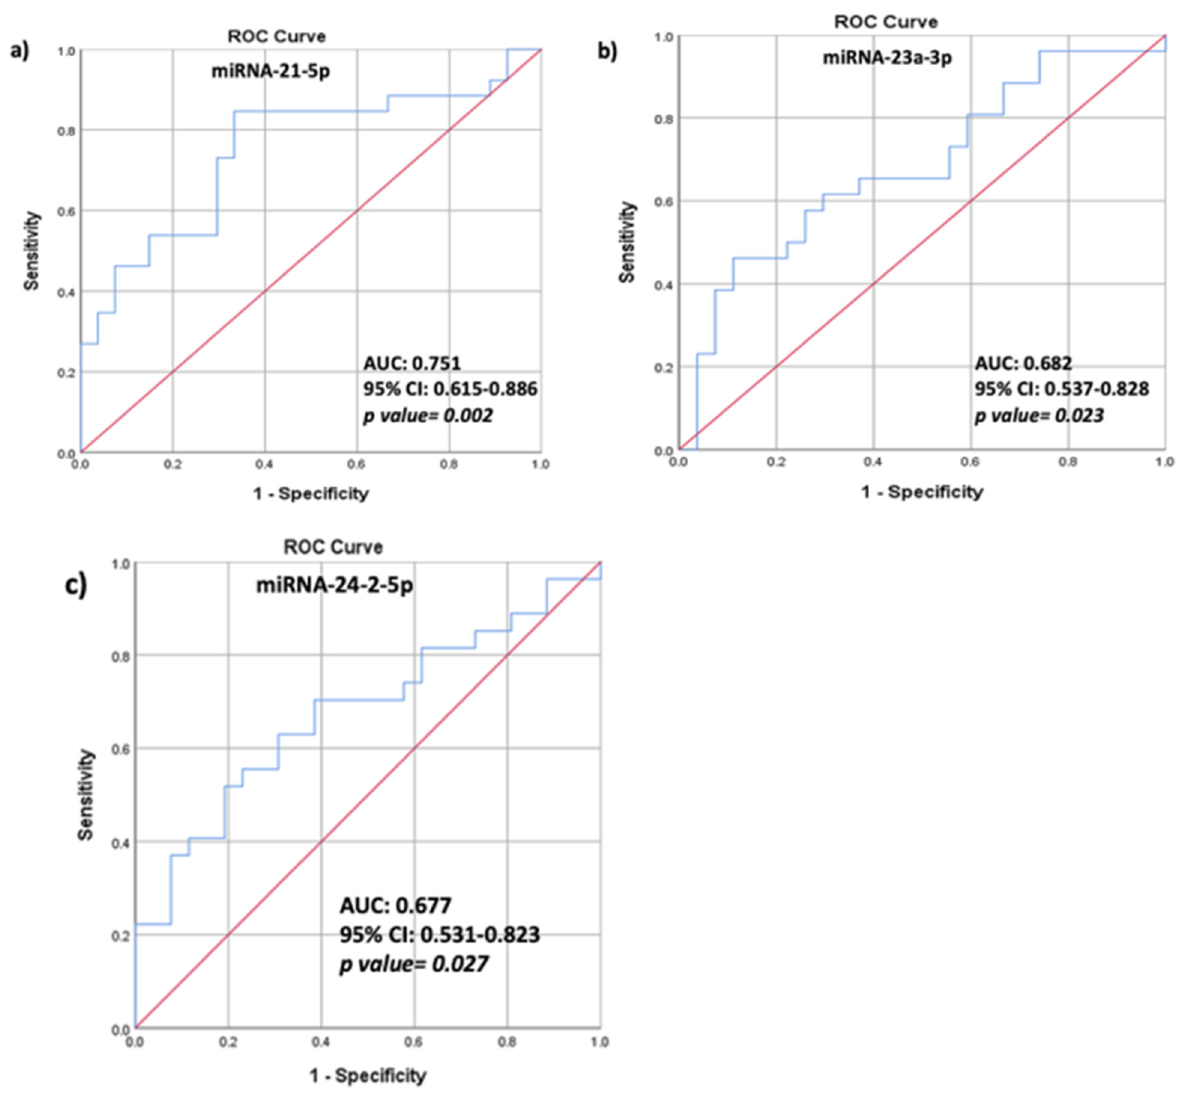
Figure 3. Area under the curve (AUC) of receiver-operating characteristic (ROC) for relative serum expression of ( a ) miRNA-21-5p, ( b ) miRNA-23a-3p, and ( c ) miRNA-24-2-5p and ROC curve in HIV+. AU, 95% confidence interval (95%CI), and nominal p values are demonstrated.